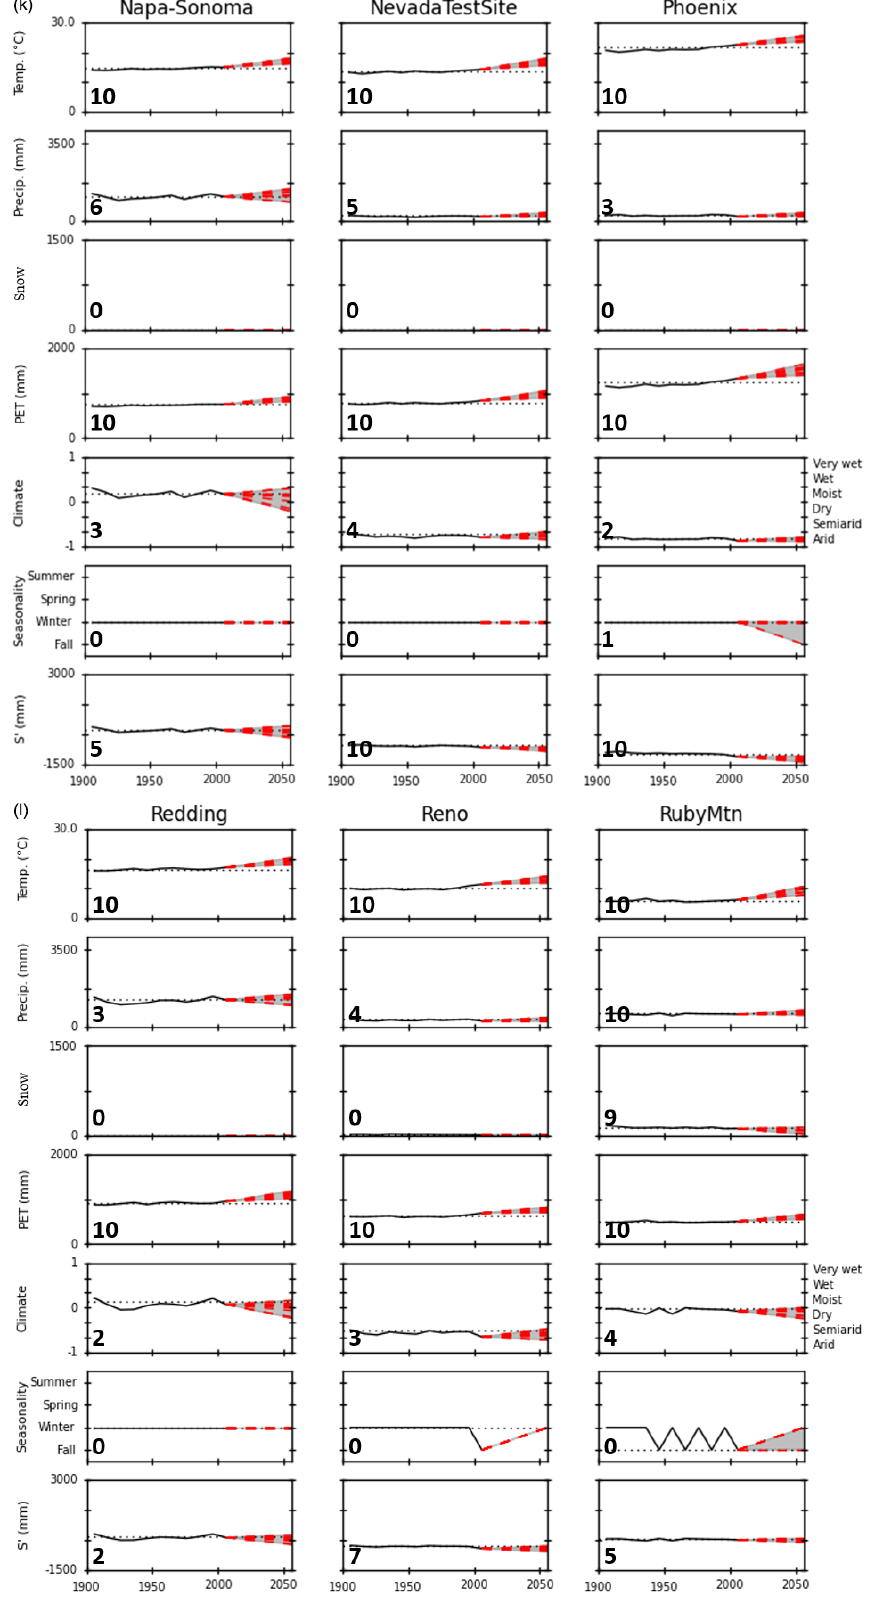
Figure A2. Hydrol. Earth Syst. Sci., 25, 3179–3206, 2021